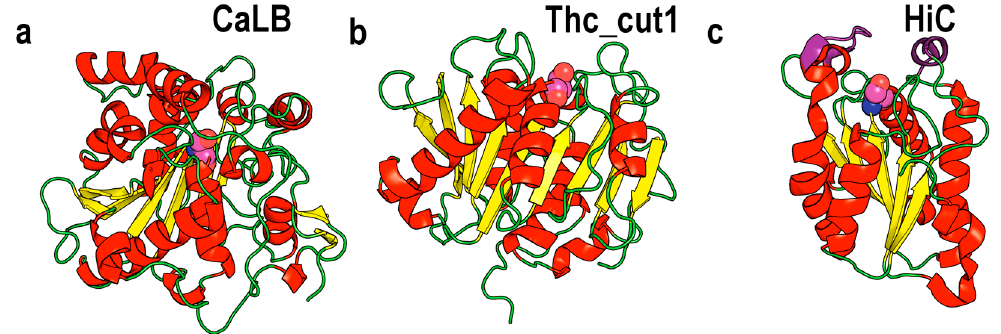
Figure 1. Representation of the 3D structures of two cutinases in comparison with CaLB: ( a ) CaLB (PDB 1TCA); ( b ) Thc_cut1 (Homology model); ( c ) HiC (PDB 4OYY). Structures are represented in cartoon mode and colored according to their secondary structure; the catalytic serine of each enzyme is highlighted in sphere mode. The mobile domains affecting active site accessibility of HiC are colored in violet.